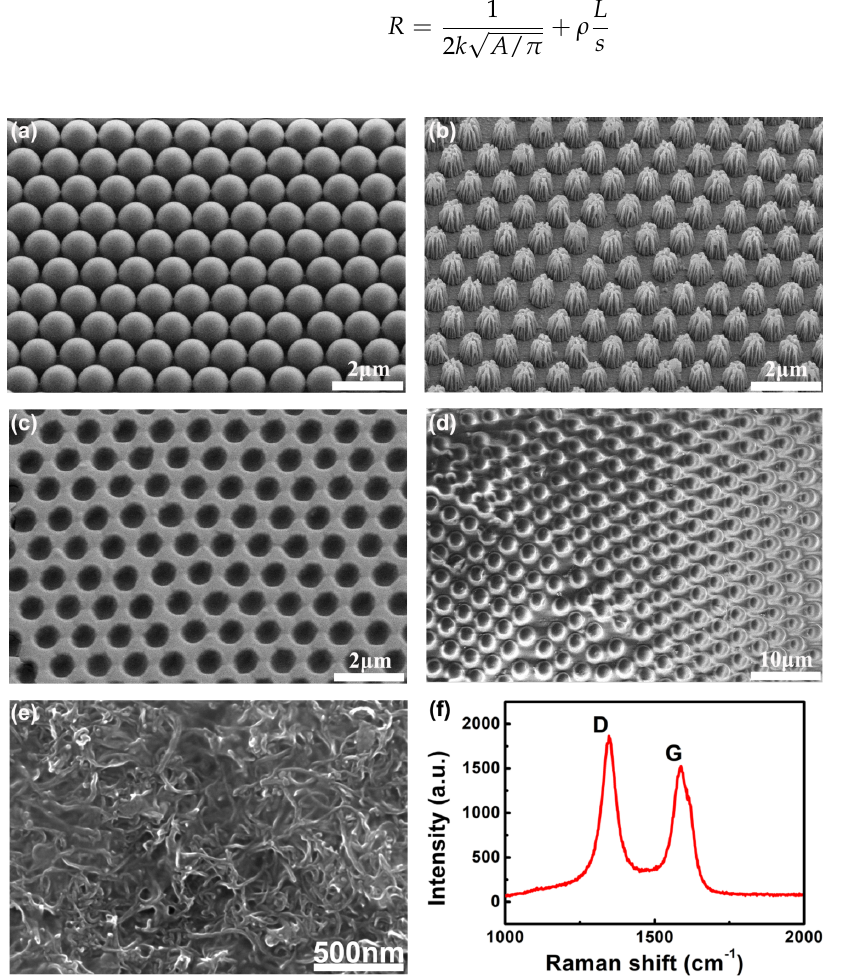
Figure 2. The SEM of fabricating flexible pressure sensor during different processes and Raman spectra of CNTs: ( a ) the monolayer PS spheres arrays on PMMA substrate; ( b ) the PS microcone array was etched with oxygen plasma after 6 min; ( c ) the SEM image of concave PDMS film by the first transferred from the PMMA microcone array template; ( d ) the PDMS’ SEM image with microcone structure; ( e ) the SEM image of the CNTs networks covered on the PDMS substrate; ( f ) Raman spectra of